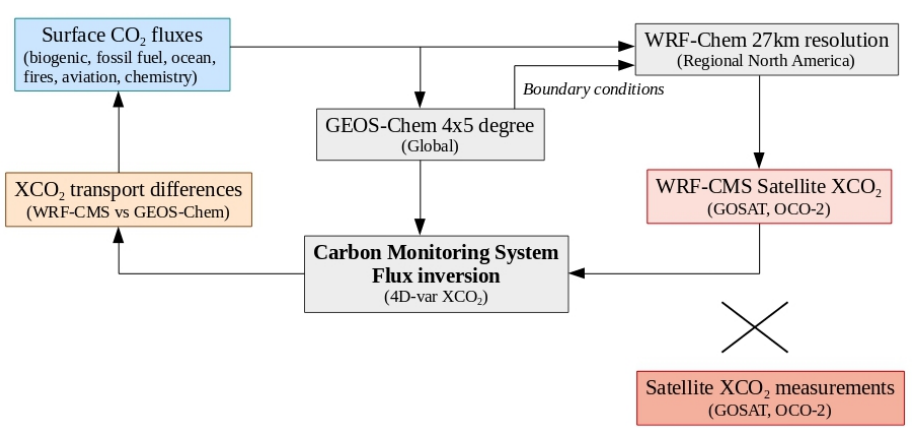
Figure A1. The coupled WRF CMS-Flux modeling environment.